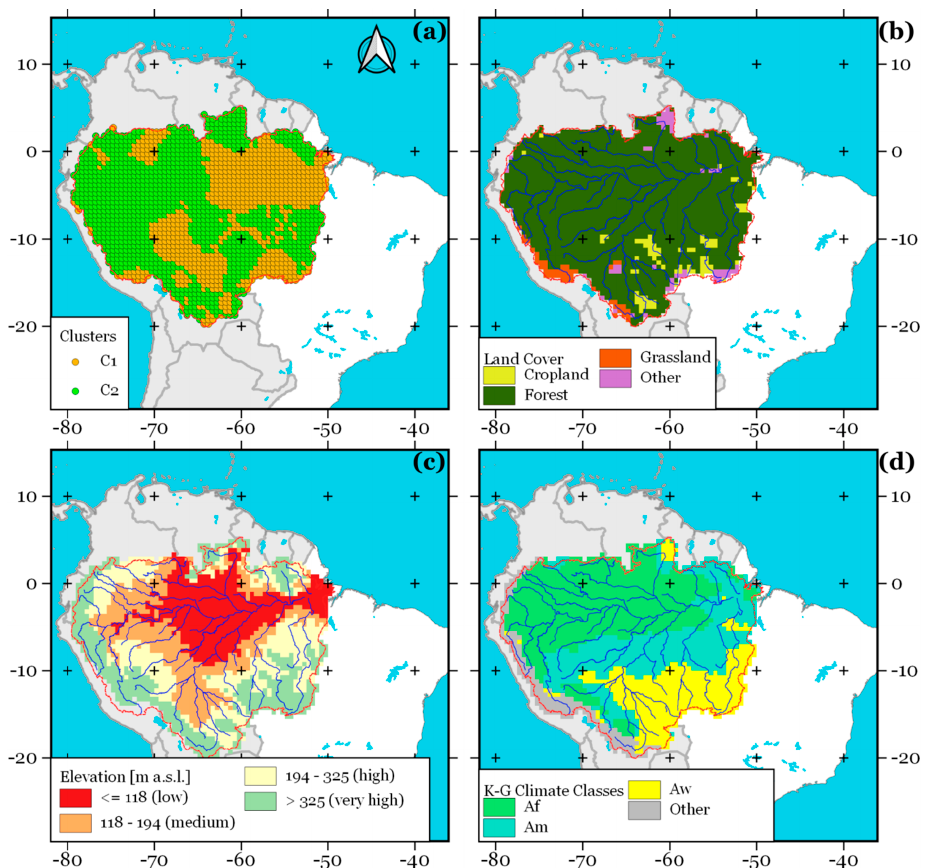
Figure 10. The spatial distribution of ( a ) the SPEI pixels according to results from cluster analysis applied to the number of dry spells [NDS], average duration of the dry spells [DDS], spatial localization of SPEI pixels, land cover, type of climate, and terrain elevation; ( b ) the land cover type; ( c ) the terrain elevation in m a.s.l.; and ( d ) the type of climate based on the Köppen-Geiger climate classification [46]. NDS and DDS are based on the time series of SPEI3, SPEI6, and SPEI12 for the period 1975-2018. The spatial localization refers to longitude and latitude in degrees for each SPEI pixel. The land cover map that is referred to is from 2018. When the local factors are analyzed in terms of NDS for the C2 region, the results reveal that the variation range of NDS for the land cover is slightly higher than that for the terrain elevation and the type of climate (not shown). Nevertheless, this finding is not necessarily indicative of the forest being more sensitive to drought than other land cover classes. The fact that forests is the predominant land cover (about 92% of the total area in the ARB) can help to explain this slight difference in NDS values between land cover classes. In other words, there is no clear evidence that the high incidence of drought in different regions of the ARB (C2 in Figure 10a) is associated to terrain characteristics, land cover, and type of climate. Overall, the results indicated that the greater part of the sub-basins Ucayali, Japu- rá-Caquetá, Jari, Jutaí, Marañón, Tapajós, and Xingu (see Figures 1c and 10a) exhibited a high incidence of dry spells (NDS > 20 events) with short durations (DDS ≤ 10 months).